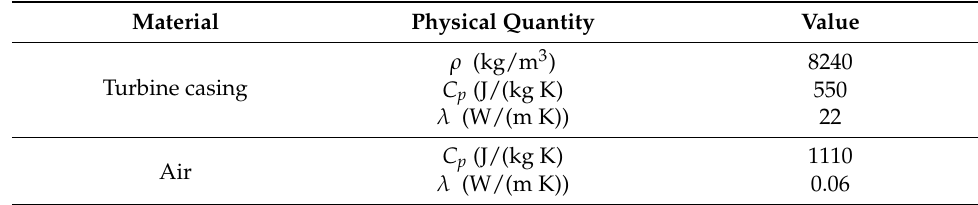
Table 2. The physical properties of the casing and the air.